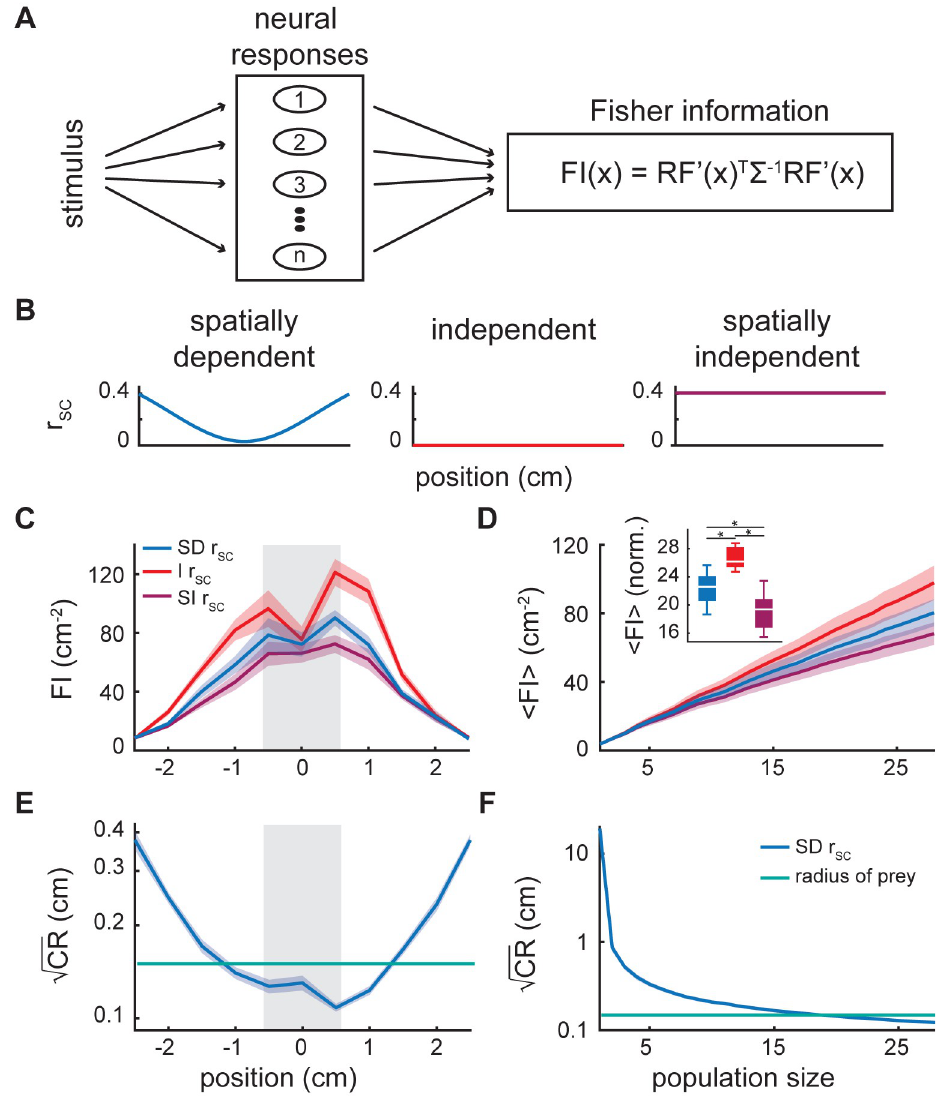
Fig 6. Redundancy reduction by spatially dependent spike-count correlations. (A) Schematic for calculating Fisher information (FI) from the neural responses (i.e., the derivative of the neural receptive fields and the covariance matrices). (B) Schematic of the different correlation scenarios used when calculating the Fisher information: the intact data which includes spatially dependent r SC (SD: left, blue), the independent case where all correlations are set to zero (I: middle, red) and the spatially independent case where the correlation values at all stimulus positions for a given pair are set to the baseline correlation for that pair (SI: right, purple). (C) Fisher information as a function of stimulus position for the three correlation scenarios, averaged over recording sessions with a population size of 28 neurons. The dip in Fisher information at position zero is caused by the slopes of many neurons in the population approaching zero as the firing rates reach their maximum. The light grey bar indicates the region of peak information and the stimulus positions over which the mean Fisher information is calculated for (D). (D) Fisher information ( < FI > ) increases linearly with population size for all three correlation scenarios over recording sessions. Inset: The boxplot of the Fisher information at a population size of 28 neurons, normalized by the Fisher information at a population size of one neuron for each recording session, shows that the three different correlation scenarios are significantly different (one- way ANOVA: df = 12, p = 3.8 � 10 − 6 ; SD—I: p = 6 � 10 − 4 ; SD—SI: p = 6.3 � 10 − 3 ; I—SI: p = 2.8 � 10 − 6 ). (E) By ffiffiffiffiffiffiffi p transforming the Fisher information to the root Crame´r-Rao bound ( , blue), the standard deviation of the prey CR location estimate can be compared to the radius of the average prey captured by the fish (0.15 cm, green line). The grey box indicates the range of positions over which averaging is done for (F). (F) The averaged root Crame´r-Rao bound ffiffiffiffiffiffiffi p ( < > ) vs neural population size decreases to below the average radius of prey at a population of ~19 neurons. CR Shaded error bars indicate the SEM in (C-F).